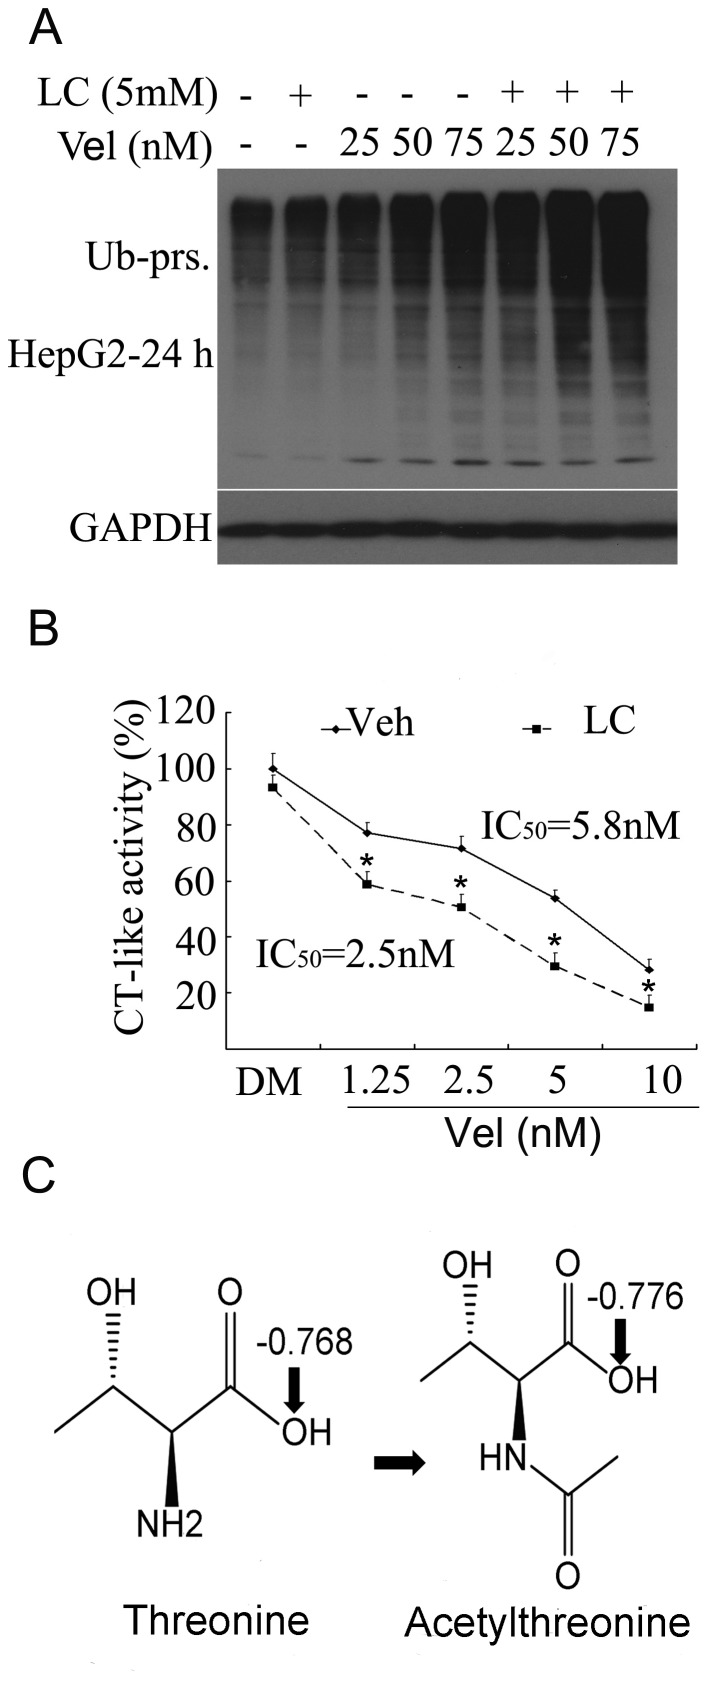
LC enhances Vel-induced proteasome inhibition.(A) HepG2 cells were treated with LC (5 mM) and/or Vel (25, 50, 75 nM) for 24 h, and ubiquitinated proteins were detected by Western blot. (B) HepG2 cells were treated with either vehicle or LC (5 mM) for 24 h, then various doses of Vel were added to the culture medium for 8 h and chymotrypsin-like (CT-like) activity in situ was detected. Mean+SD (n = 3). *P<0.05, compared with the control at each point. (C) The natural bond Orbital (NBO) charge and geometric optimization were calculated by the DFT method and the NBO charges in the hydroxyl O atom of threonine or acetylthreonine was shown.